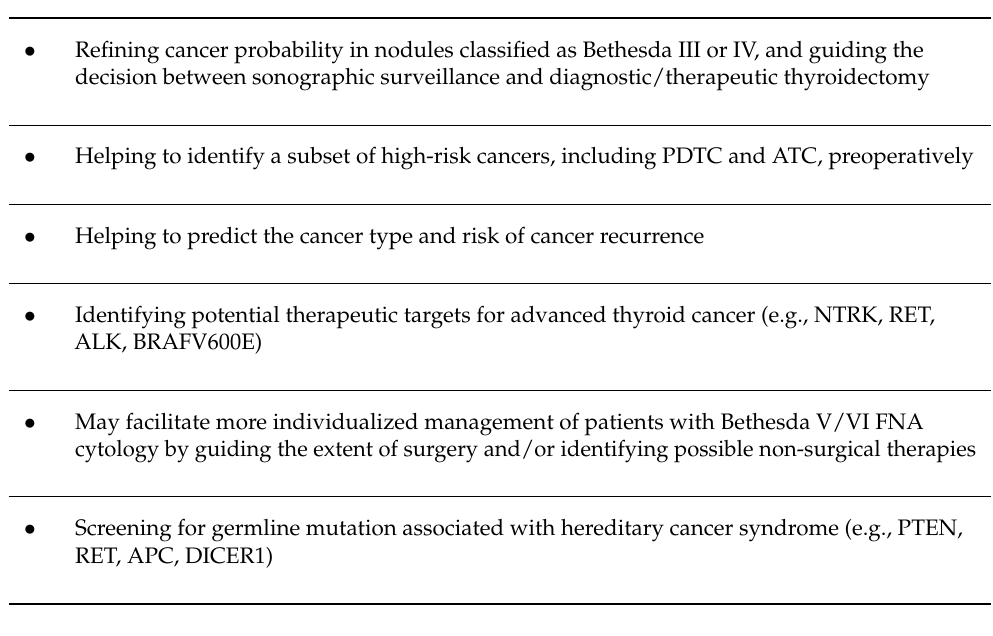
Table 1. Potential advantages of molecular tests for thyroid nodules and advanced thyroid cancers